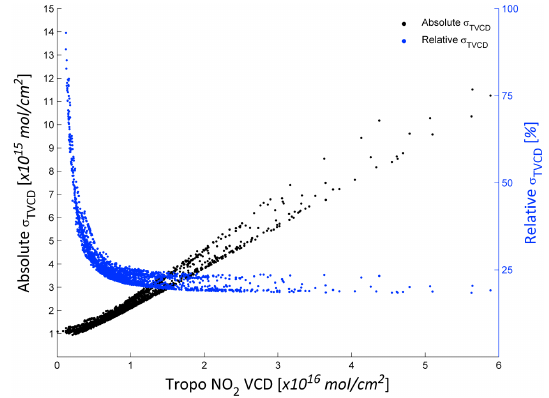
Figure 5. Overall absolute and relative errors ( σ TVCD ) on the re- trieved NO 2